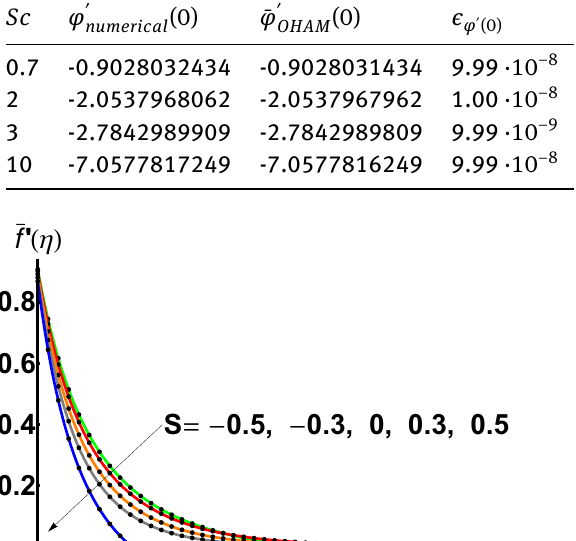
The obtained results are in agreement with the fluid flow scenario from a hydraulic installation for different values of the characteristic quantities: U